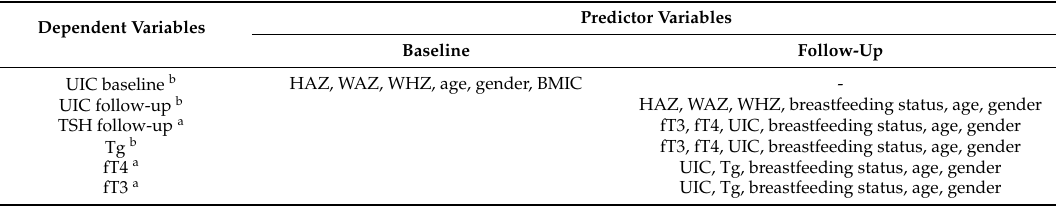
Table 1. Overview of predictor variables used in linear regression models for the dependent variables UIC baseline, UIC follow-up, TSH, Tg, fT3 and